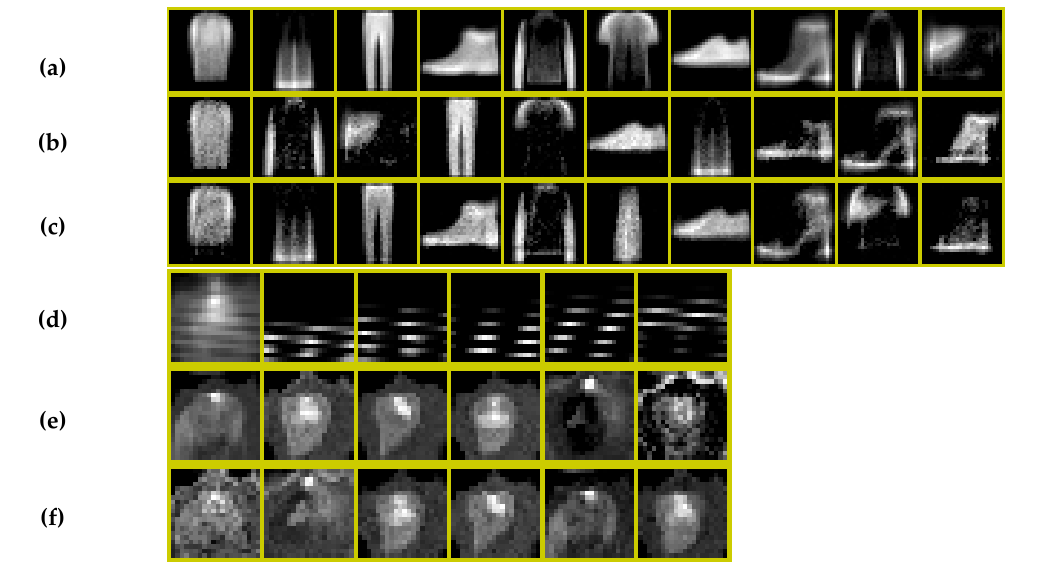
Figure 10. Fashion data ( a ) LDA topics with 10,000 images, ( b ) LDA topics with 1000 images, ( c ) ERT model with 1000 images and Tungsten Inert Gas (TIG) data ( d ) LDA topics with 10,000 images, ( e ) LDA topics with 1000 images, ( f ) ERT model with 1000 images.